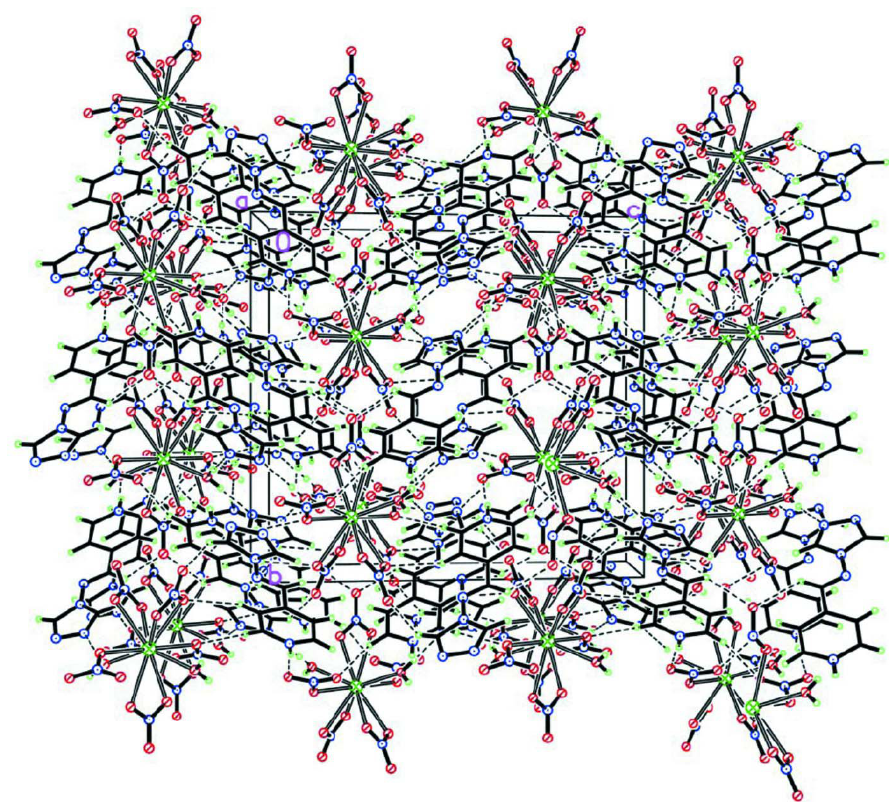
Figure 2 A packing diagram of the title compound along a axis. The dash lines indicate hydrogen